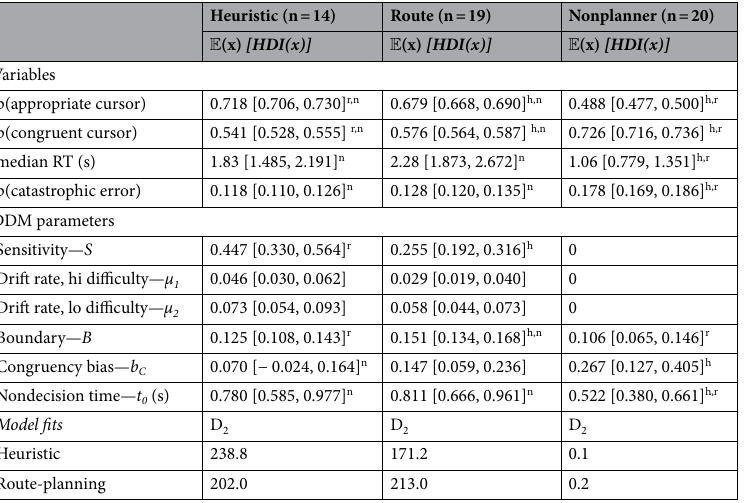
Table 1. Group-specific posteriors for variables and DDM parameters and model fit scores. E (x) = expected value of posterior x, HDI(x) = highest density interval of posterior x. Credible difference between a given posterior and that of the heuristic, route and nonplanner group is respectively superscripted h , r , and n . Values for p (congruent cursor), p (appropriate cursor) and p (catastrophic error) relate to group-level probability (θ v,g : see methods) from a summary binomial model. Values for all other variables and parameters describe group-level mean ( Μ v,g : see methods) from a summary Gaussian model. Sensitivity ( S ) is measured as ( μ 1 + μ 2 )/ ( 2B ( 1 + |b C | )). Model fits assessed with residual deviance ( D 2 ) where higher scores reflect better model fits across a group’s participants relative to the null